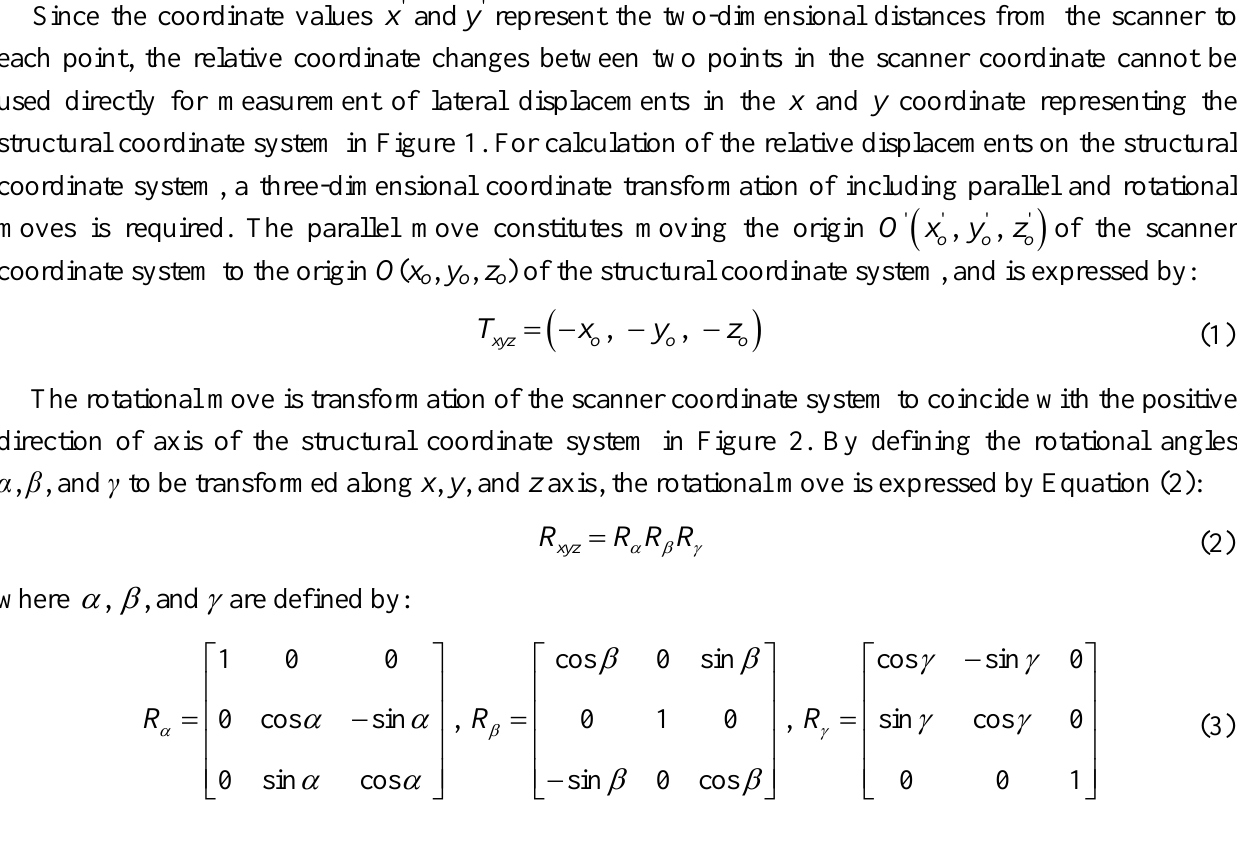
Figure 2. Coordinate transformation from scanner to building